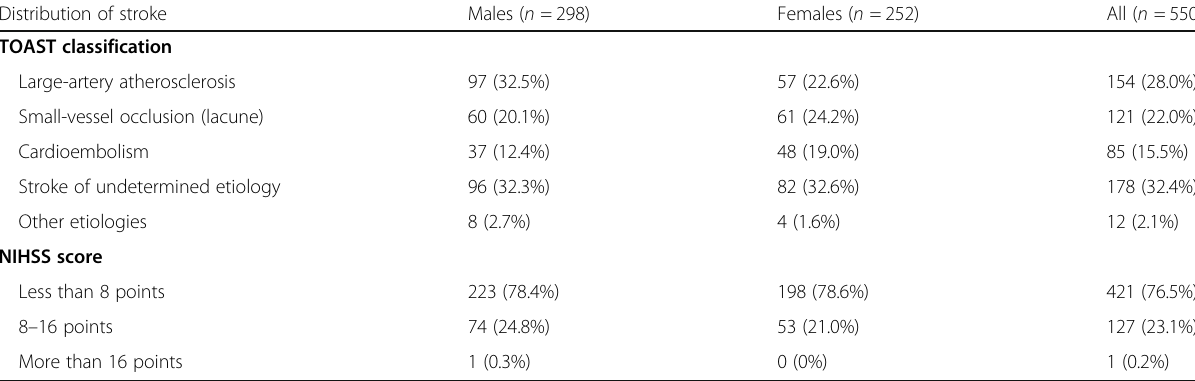
Table 2 Distribution of patients with stroke according to TOAST classification and NIHSS score Distribution of stroke TOAST